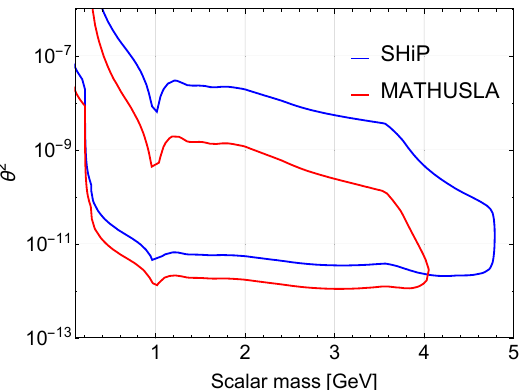
Figure 13 . Comparison of sensitivities of the SHiP and MATHUSLA experiments for the scalar portal model. In the case of the SHiP experiment we used the overall efficiency (cid:26) = 0 . 2, see the text for details. In the case of the MATHUSLA experiment we optimistically used (cid:26) detection efficiency. We used the scalar phenomenology described in